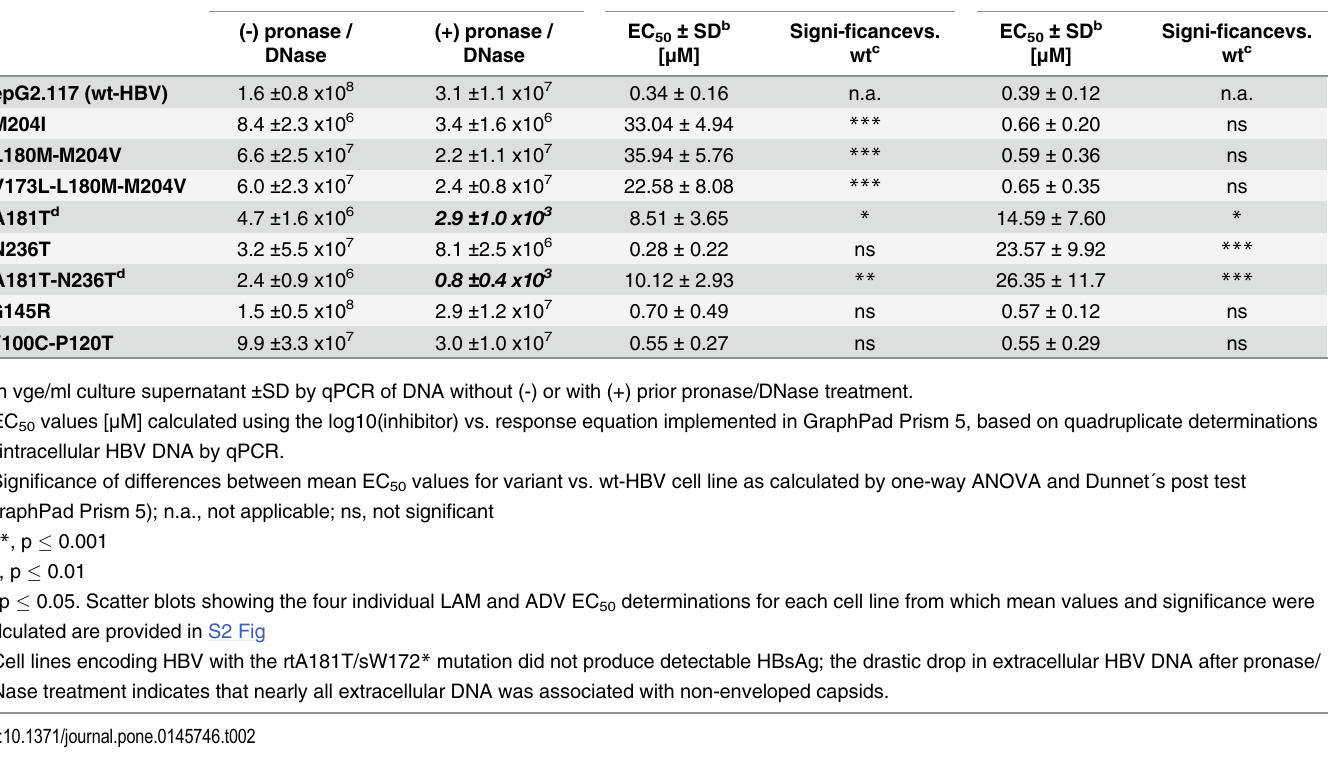
Table 2. Titers of HBV DNA in extracellular particles and LAM and ADV EC 50 values for cell line-encoded wt-HBV and HBV variants. Cell